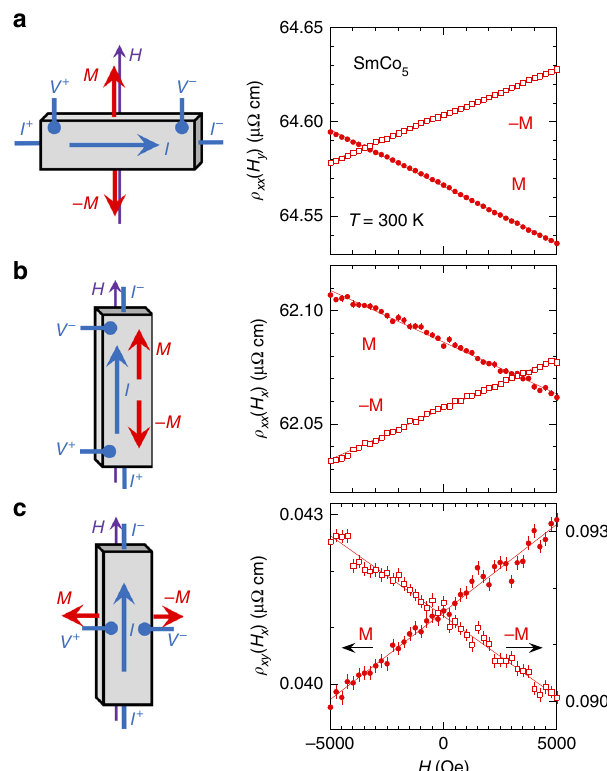
Fig. 1 Ferromagnetism-induced antisymmetric linear magnetoresistance and the planar Hall effect. Using a fi xed geometry relative to the fi eld (schematics), ρ ( H ) is plotted for three types of galvanomagnetic behavior, a transverse MR, b longitudinal MR, and c the planar Hall effect, relative to two different magnetic states M and − M in SmCo 5 samples. The magnetization is set by a fi eld (±14 T) that is much larger than the measuring fi eld (±0.5 T). In all three cases, antisymmetric linear MR of opposite slopes was observed. The two-way switching behavior rules out trivial explanations arising from imperfections in the contact geometry, and pinpoints the origin in a magnetization that is independent of the measurement fi eld. Vertical error bars represent 1 σ s.d.